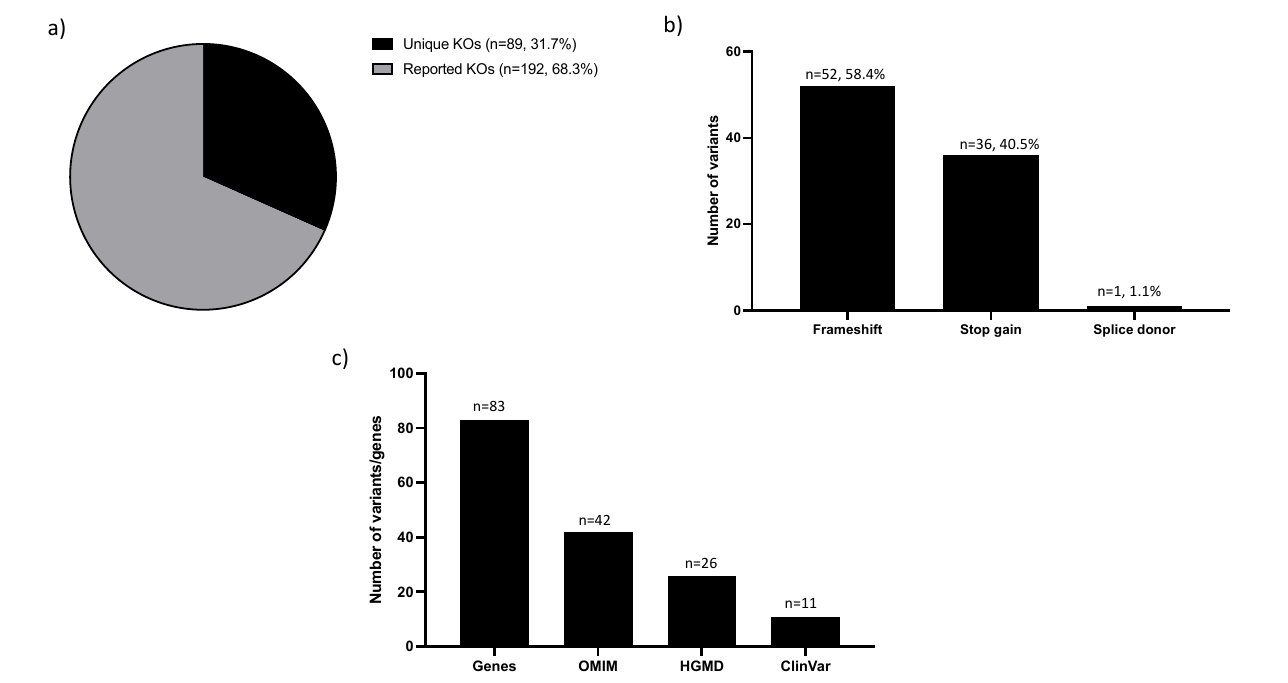
Figure 3. Characterization of high confidence knockouts (KOs) in the MEV database. ( a ) Distribution of unique (present in MEV database only) and reported (present in both MEV database and gnomAD) knockouts. ( b ) Effects of unique KOs variants. Number of variants = Number of stops gained, frameshift, splice acceptor, stop lost, and splice donor variants. ( c ) Distribution of unique KOs genes in different disease databases (ClinVar, HGMD, and OMIM). Number of variants = Number of variants in OMIM, CLinVar, and HGMD. Number of genes = Number of genes in Unique KOs.